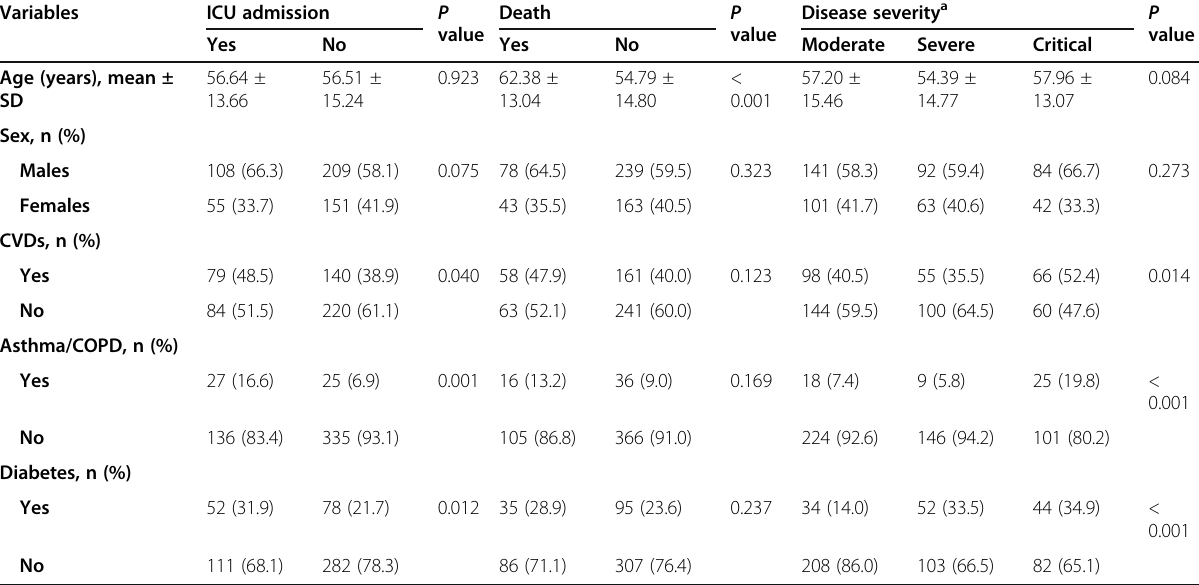
Table 3 Distribution of baseline information by adverse clinical outcomes of COVID-19